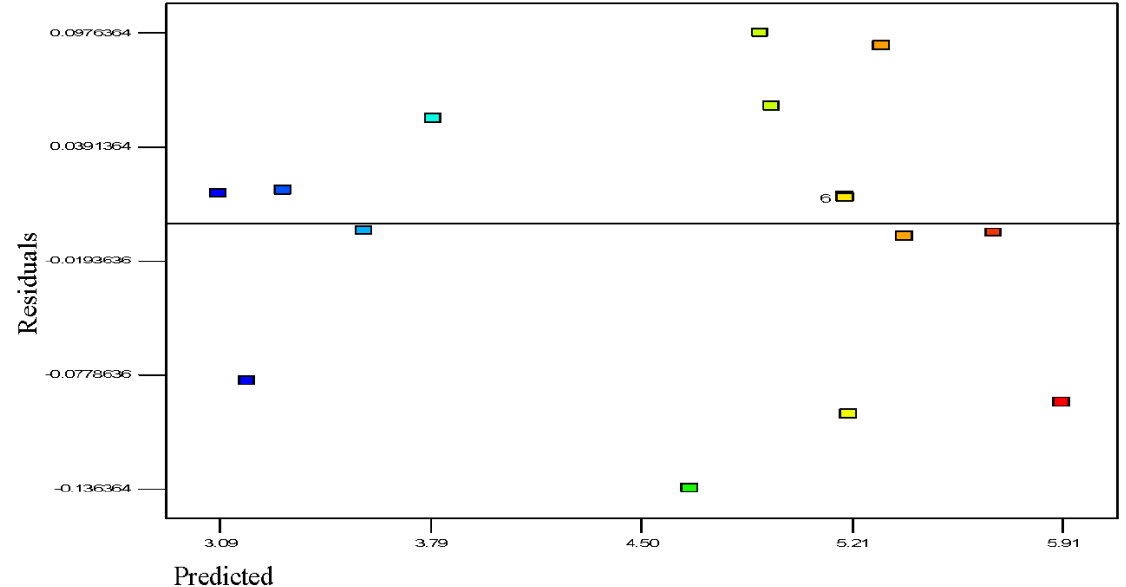
Figure 5. The residuals and predicted response plot for propylene polymerization.